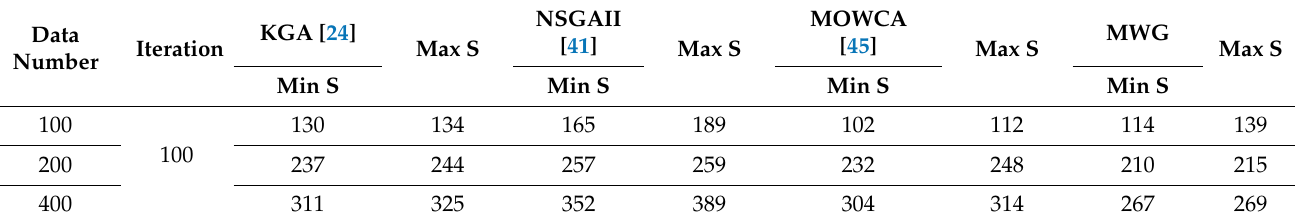
Table 6. Metric of spacing for different algorithms.